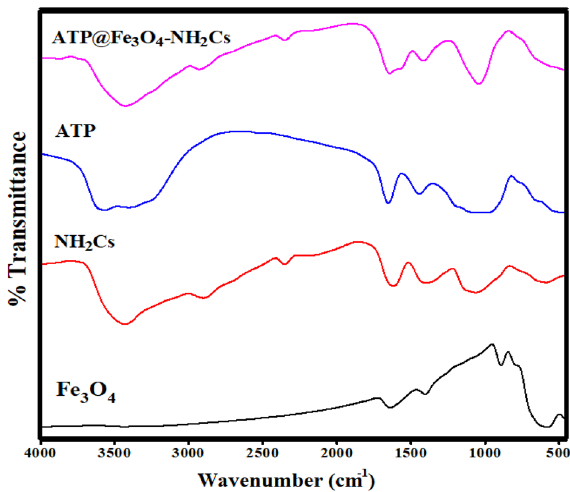
Figure 2. FTIR of Fe 3 O 4 , NH 2 Cs, ATP and ATP@Fe 3 O 4 -NH 2 Cs